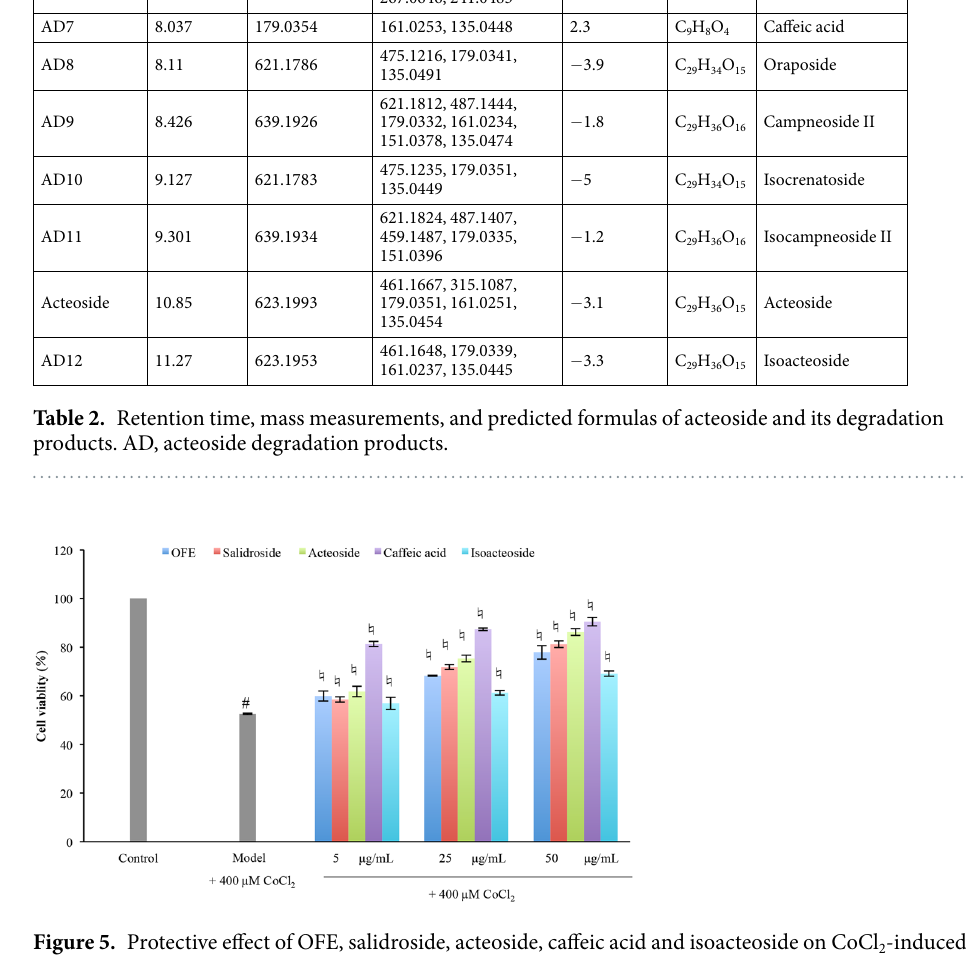
Figure 5. Protective effect of OFE, salidroside, acteoside, caffeic acid and isoacteoside on CoCl 2 -induced hypoxia damage in PC-12 cell. OFE, O. fragrans var. thunbergii flower extracts; the 5, 25 and 50 μ g/mg were the contents of total phenylethanoid glycoside in OFE. Cell viabilities were measured by CCK-8 assay. # p < 0.05 compared with control group; ♮ p < 0.05 compared with model group ( + 400 µ M CoCl 2